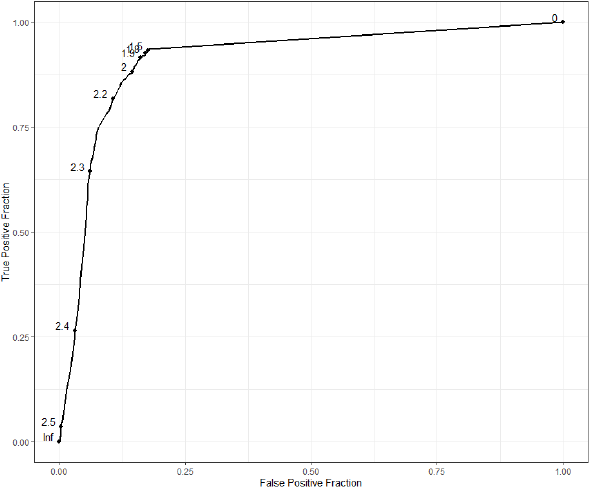
Figure 4. ROC curve analysis of blind test for determination of the optimal LSV cut-off.